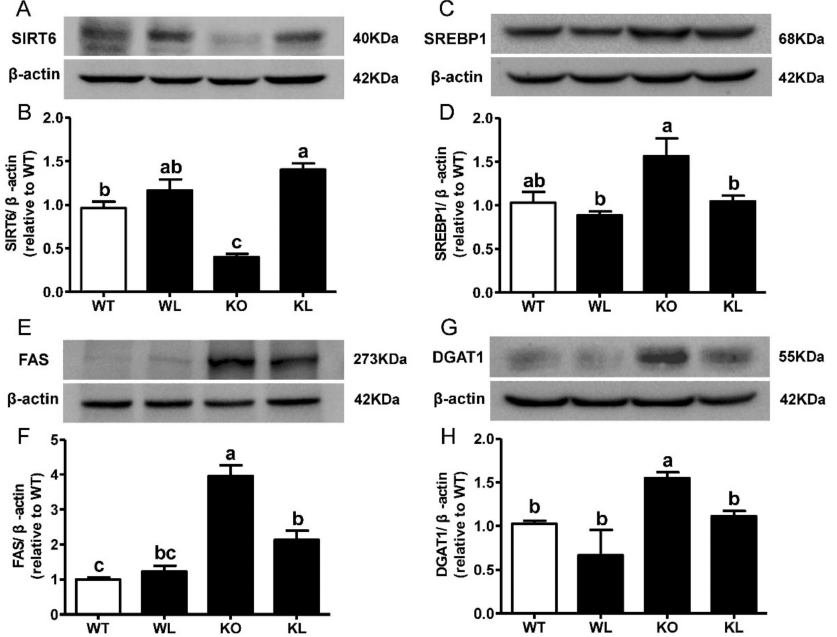
Figure 6. LWE decreased hepatic lipogenic related protein expression in the Lepr − / − rats. ( A – H ) Representative figure and summarized data for SIRT6, SREBP1, FAS and DGAT1. Values are means ± SEM (n = 3–4). Columns with different letters are significantly different ( p <